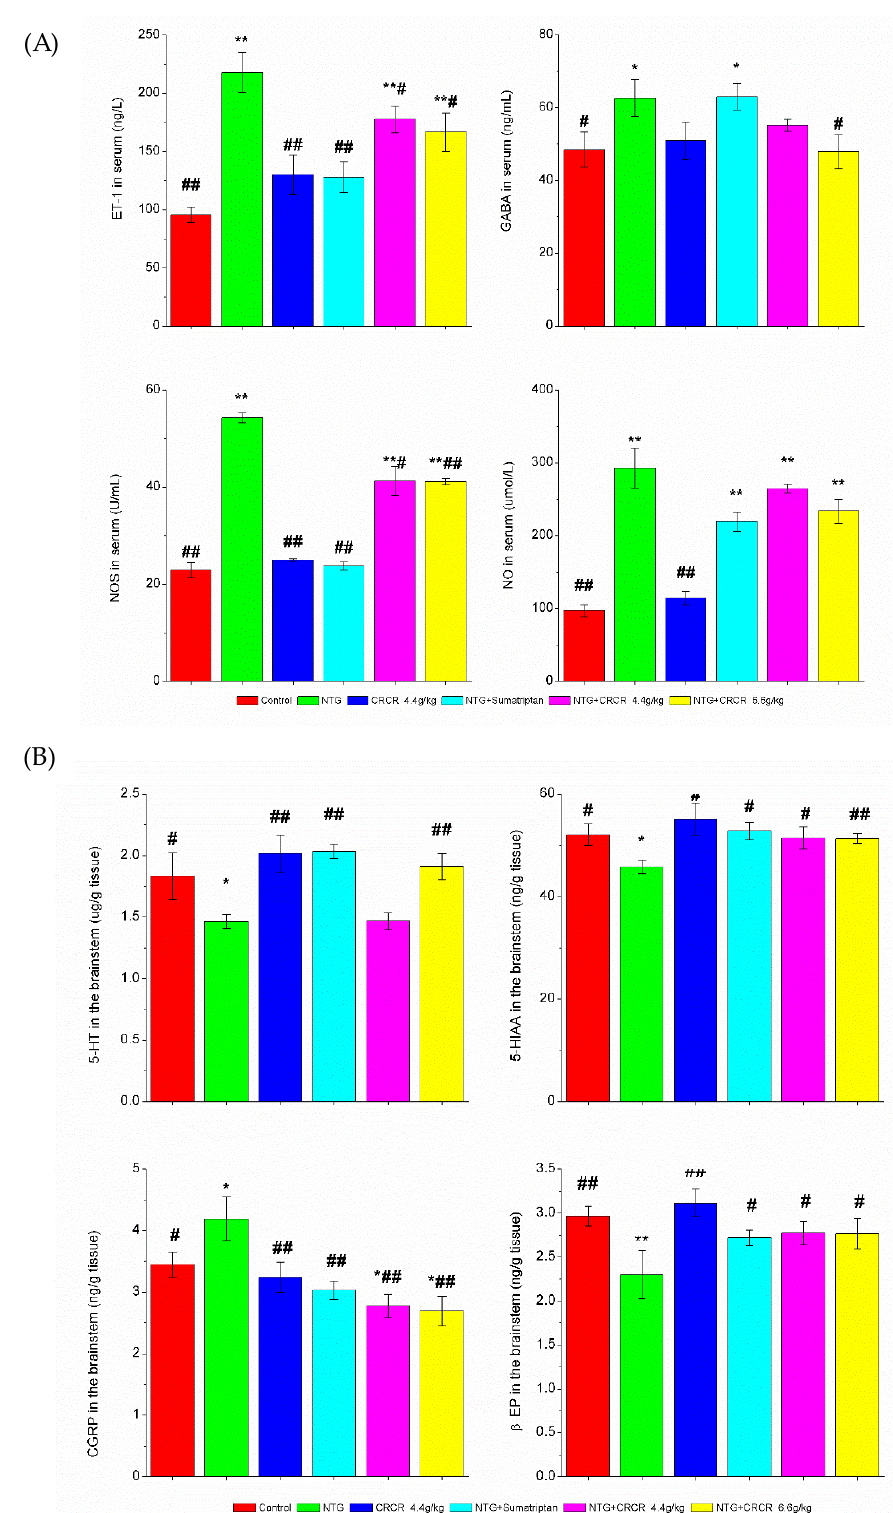
Figure 2. E ff ects of CRCR on ET-1, GABA, NOS, NO, 5-HT, 5-HIAA, CGRP and β -EP levels detected by Figure 2 . Effects of CRCR on ET-1, GABA, NOS, NO, 5-HT, 5- HIAA, CGRP and β -EP levels ELISA. ( A ) ET-1, GABA, NOS and NO levels in the serum. ( B ) 5-HT, 5-HIAA, CGRP and β -EP levels in detected by ELISA. ( A ) ET-1, GABA, NOS and NO levels in the serum. ( B ) 5-HT, 5-HIAA, the brainstem. Data are expressed as mean ± S.E. * p < 0.05, ** p < 0.01 vs. control group, # p < 0.05, CGRP and β -EP levels in the brainstem. Data are expressed as mean±S.E. * p < 0.05, ** p < 0.01 vs ## p < 0.01 vs. NTG control group, # p < 0.05, ## p < 0.01 vs NTG group.